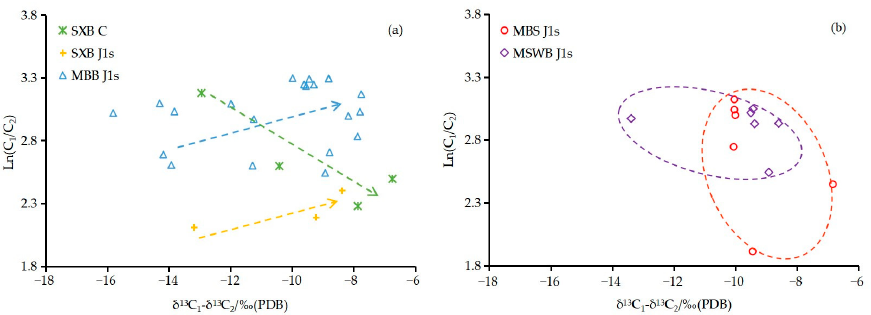
Figure 10. Relationship of δ 13 C 1 - δ 13 C 2 vs. Ln(C 1 /C 2 ) in the eastern belt around the Penyijingxi sag, Junggar Basin (Plate from ref. [54]).